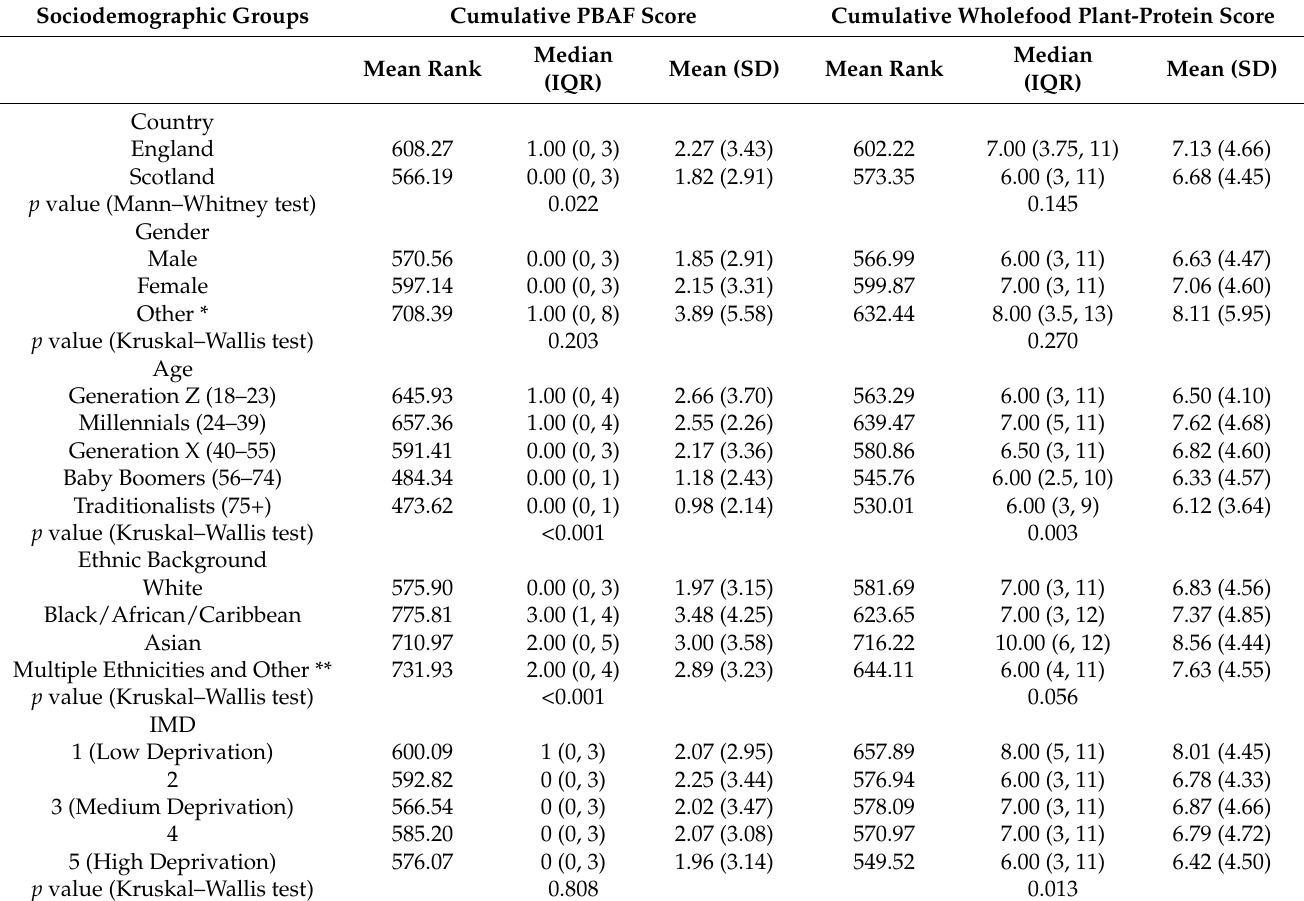
Table 4. Distribution of Purchase Amounts of product types within sociodemographic